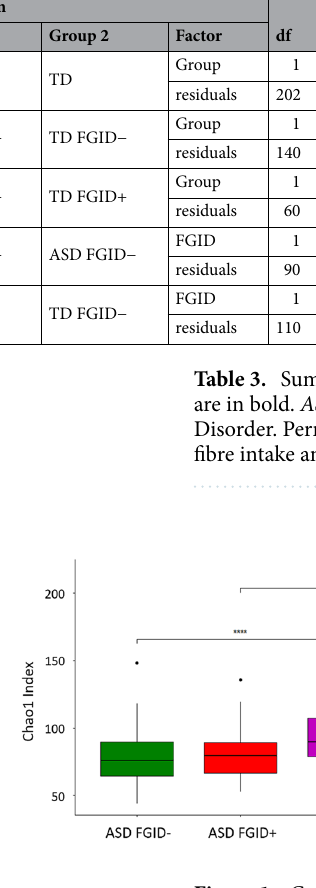
Figure 1. Comparison of alpha diversity (the Chao1 Index and the Faith’s Phylogenetic Diversity) between ASD FGID−, ASD FGID+, TD FGID−, and TD FGID+; *p < 0.05, **p < 0.01, ***p < 0.001, ****p <